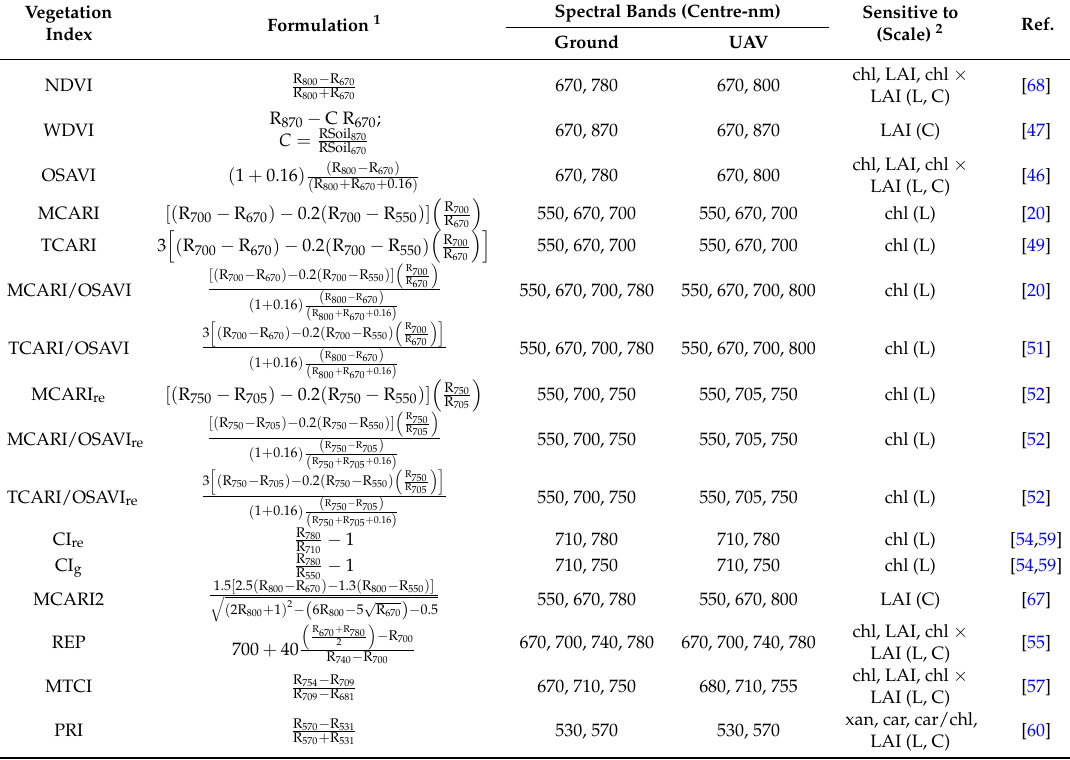
Table 2. Vegetation indices used to estimate crop